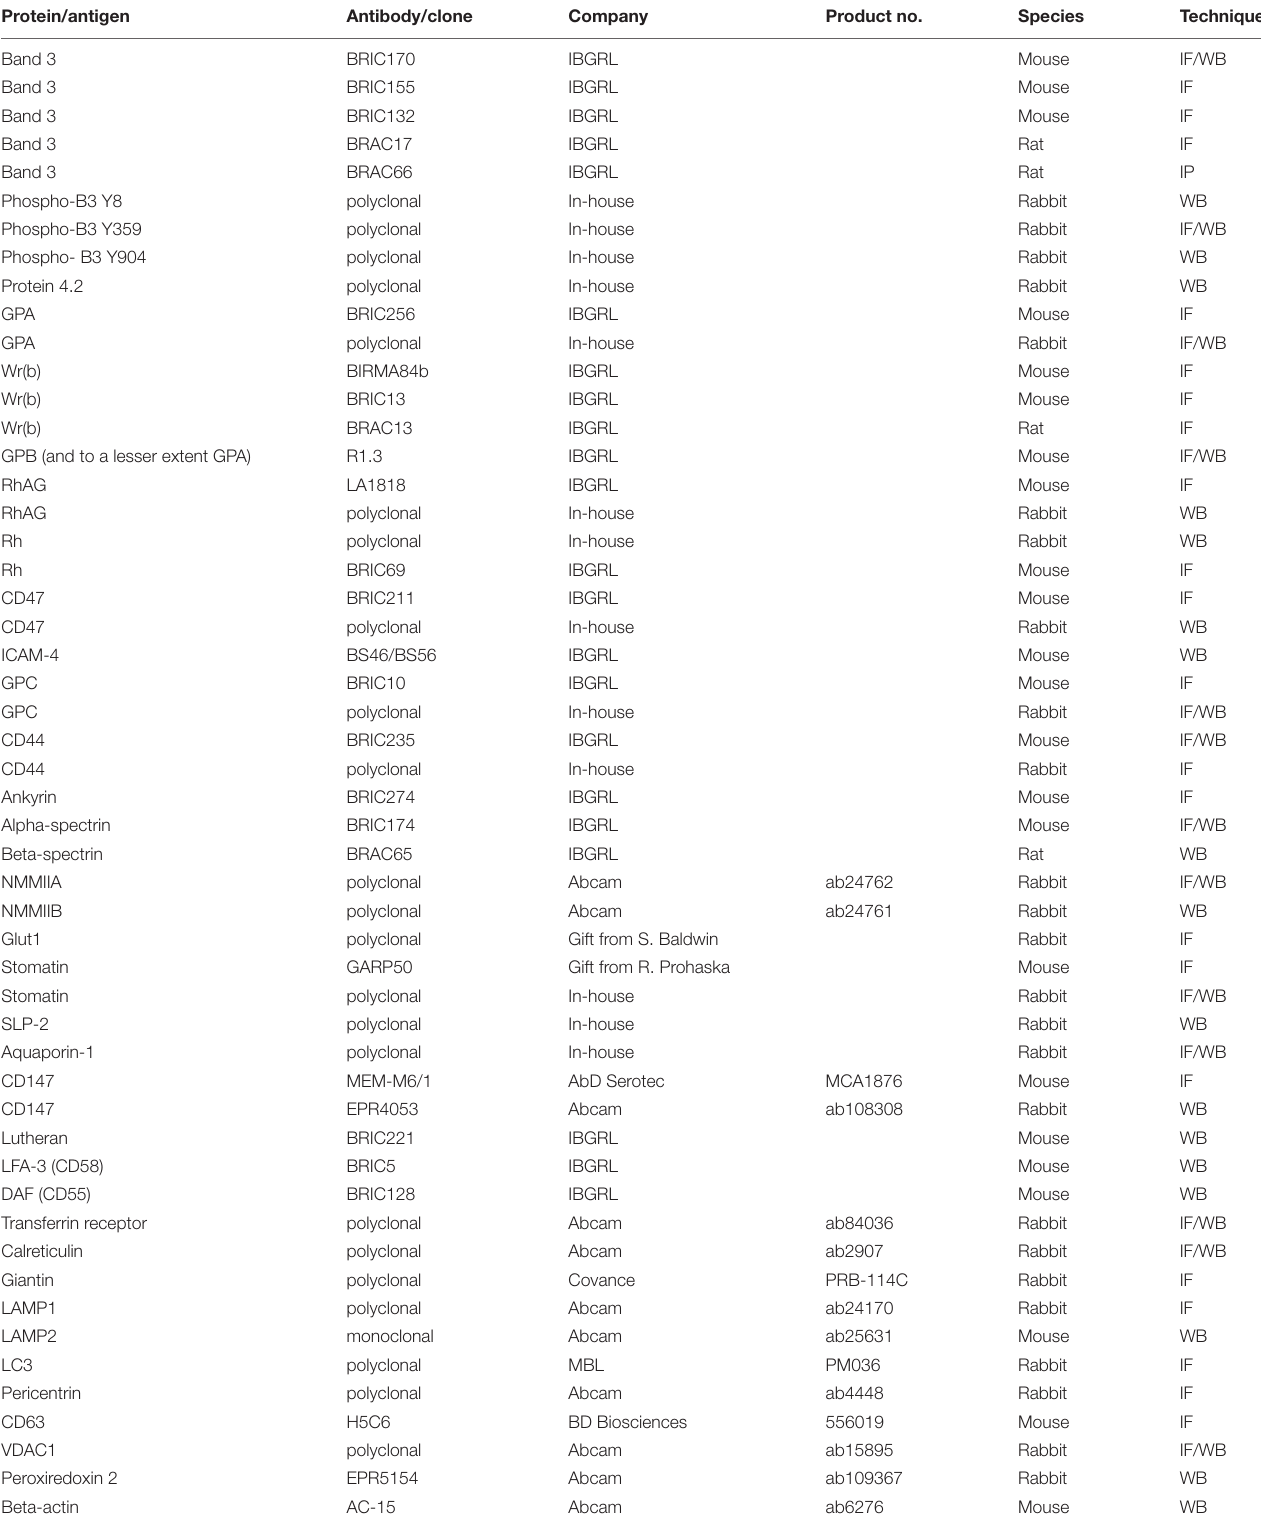
TABLE 1 | Antibodies used in the